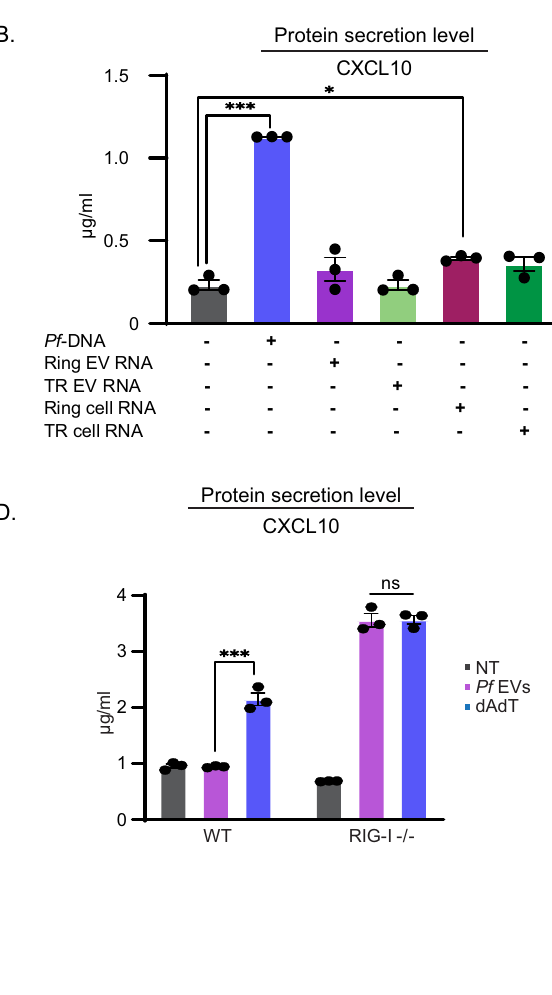
RNase H RNase I